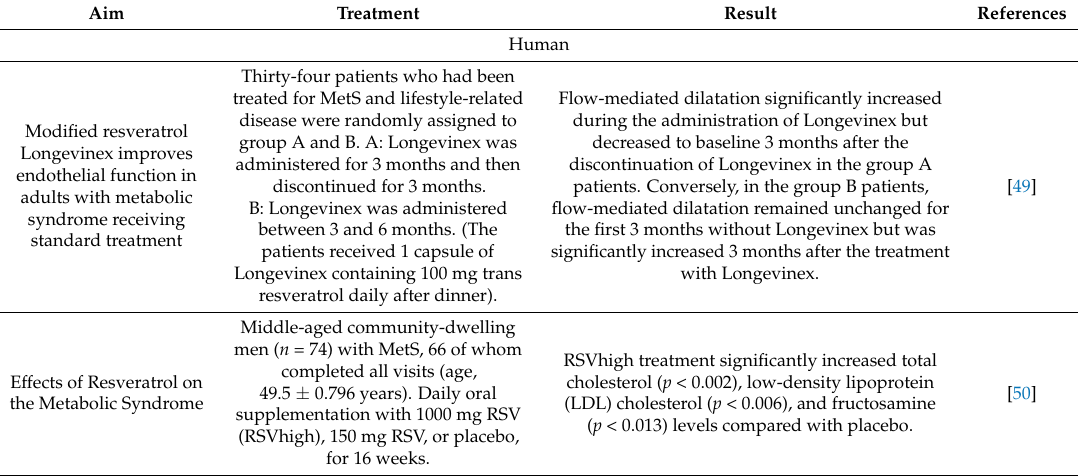
Table 1. Summary of clinical and animal studies of resveratrol in metabolic